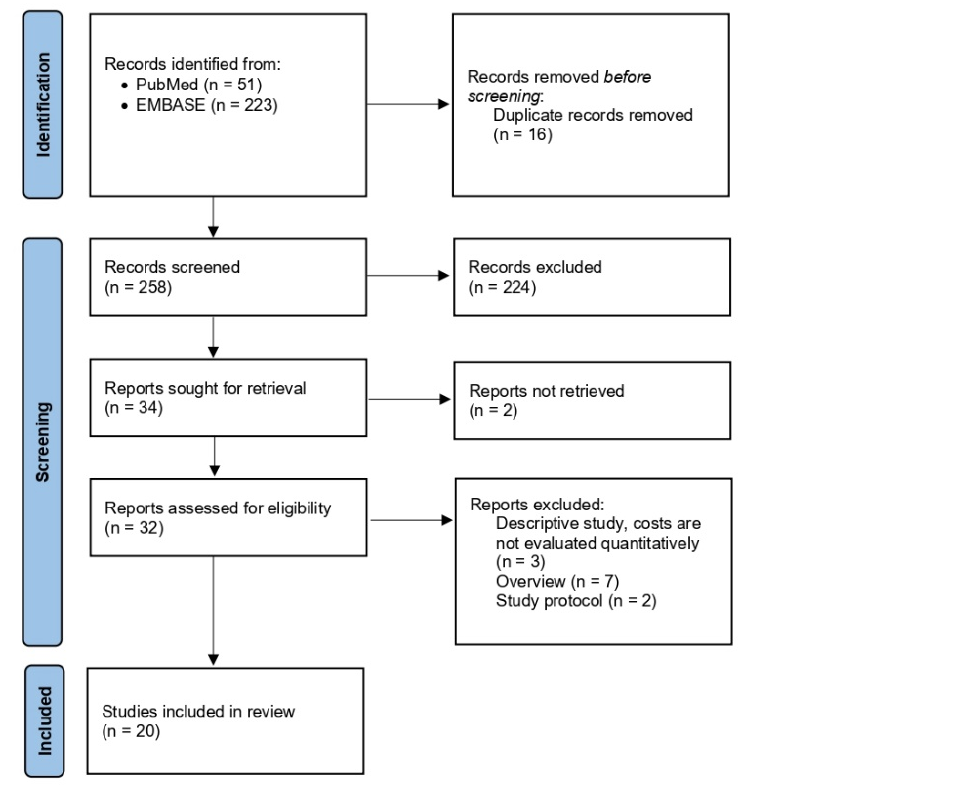
Figure 1. PRISMA diagram of the review’s systematic searches.